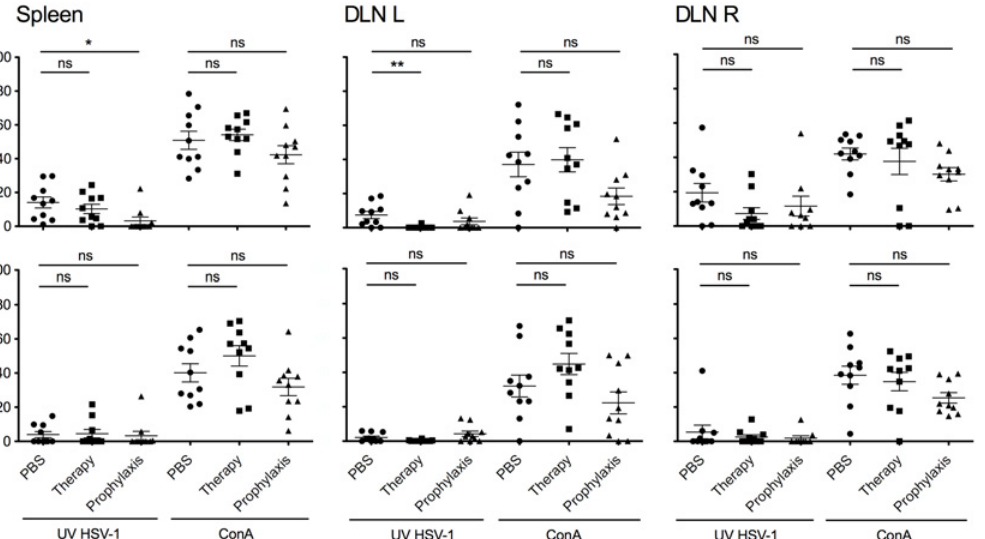
Figure 7. Proliferative response of CD4 + and CD8 + lymphocytes after mAb 2c application. Lymphocytes derived from spleens or DLNs (R = ipsilateral, L = contralateral) of HSV-1 KOS infected mice receiving prophylactical or postexposure treatment (therapy) with mAb 2c were stimulated either with UV ‑ inactivated HSV-1 or Concavalin A for four days. Proliferation of CD4 + and CD8 + lymphocytes was determined by flow cytometry. Differences between the groups were statistically significant as calculated by a nonparametric ANOVA one way test ( * P < 0.05; ** P < 0.01). Error bars represent the